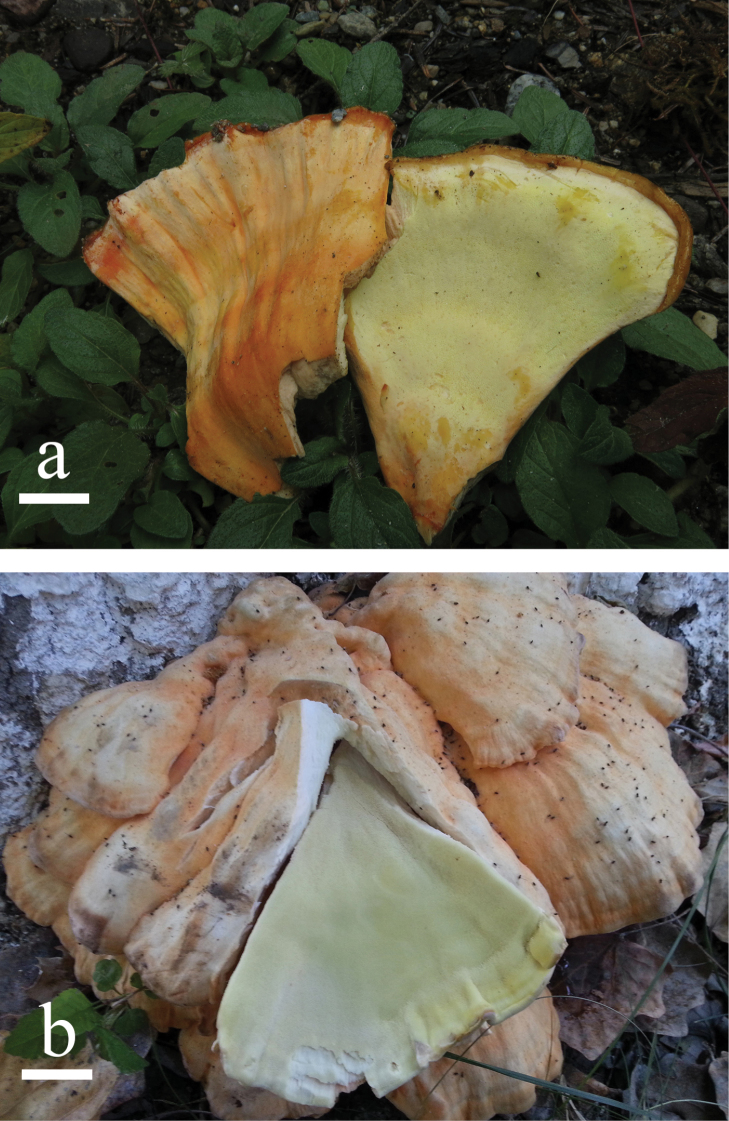
Basidiomata of Laetiporus species. aL.medogensisbL.xinjiangensis. Scale bars: a = 2 cm, b = 3 cm.